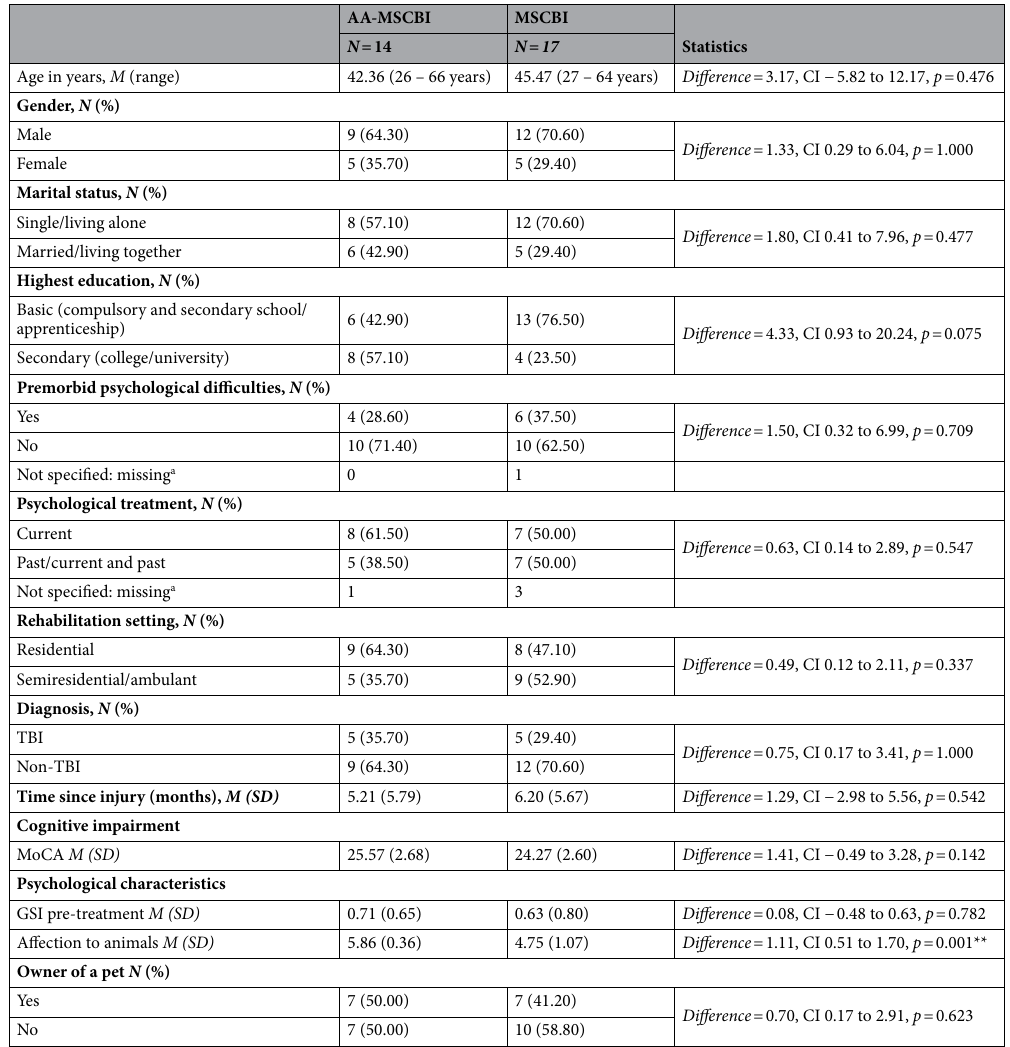
Table 1. Baseline demographics and sample characteristics. AA-MSCBI animal-assisted psychotherapeutic mindfulness- and self-compassion-based group intervention, MSCBI standard psychotherapeutic mindfulness- and self-compassion-based group intervention, N number of patients, % percentage of patients, TBI traumatic brain injury, Non-TBI non-traumatic brain injury, M mean, SD standard deviation, MoCA Montreal Cognitive Assessment, GSI Global Severity Index of the Brief Symptom Inventory reflecting patients’ general psychological distress, a : not included in analysis, ** p <